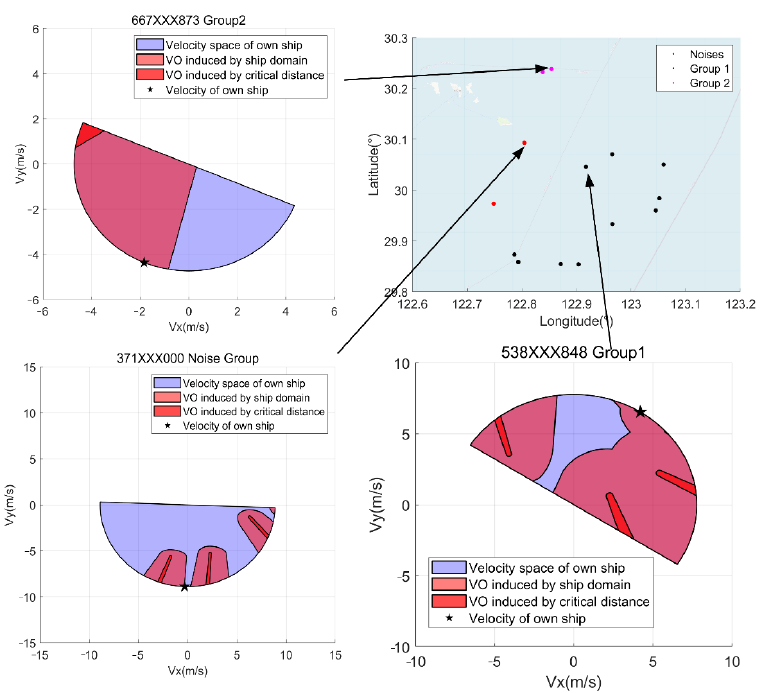
Figure 7. Visualization of Ship clustering and TCR of random ship in the groups at 18:56:30.